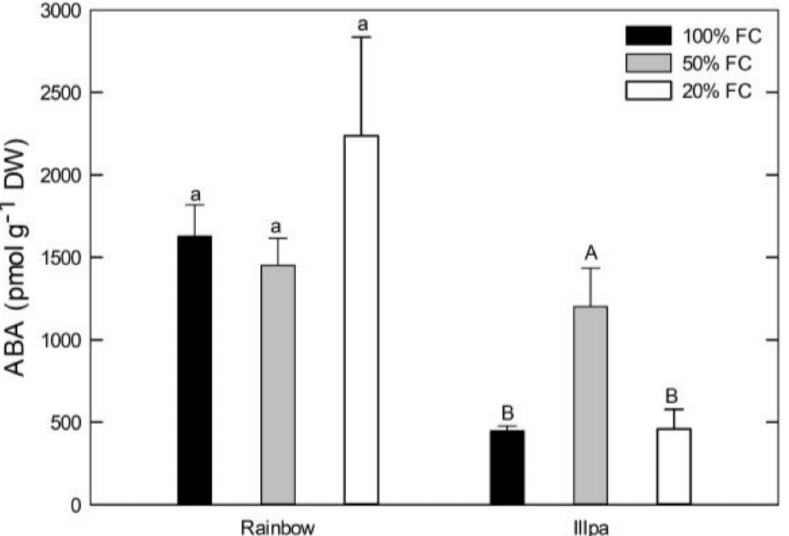
Figure 6. Leaf ABA concentration (pmol g − 1 DW) in two quinoa cultivars (Rainbow and Illpa) grown under irrigation regimes of 100% substrate holding full capacity (FC), 50% FC or 20% FC. The same letters indicate no significant di ff erences among treatments for a given cultivar ( p < 0.05). Mean ± SE ( n =